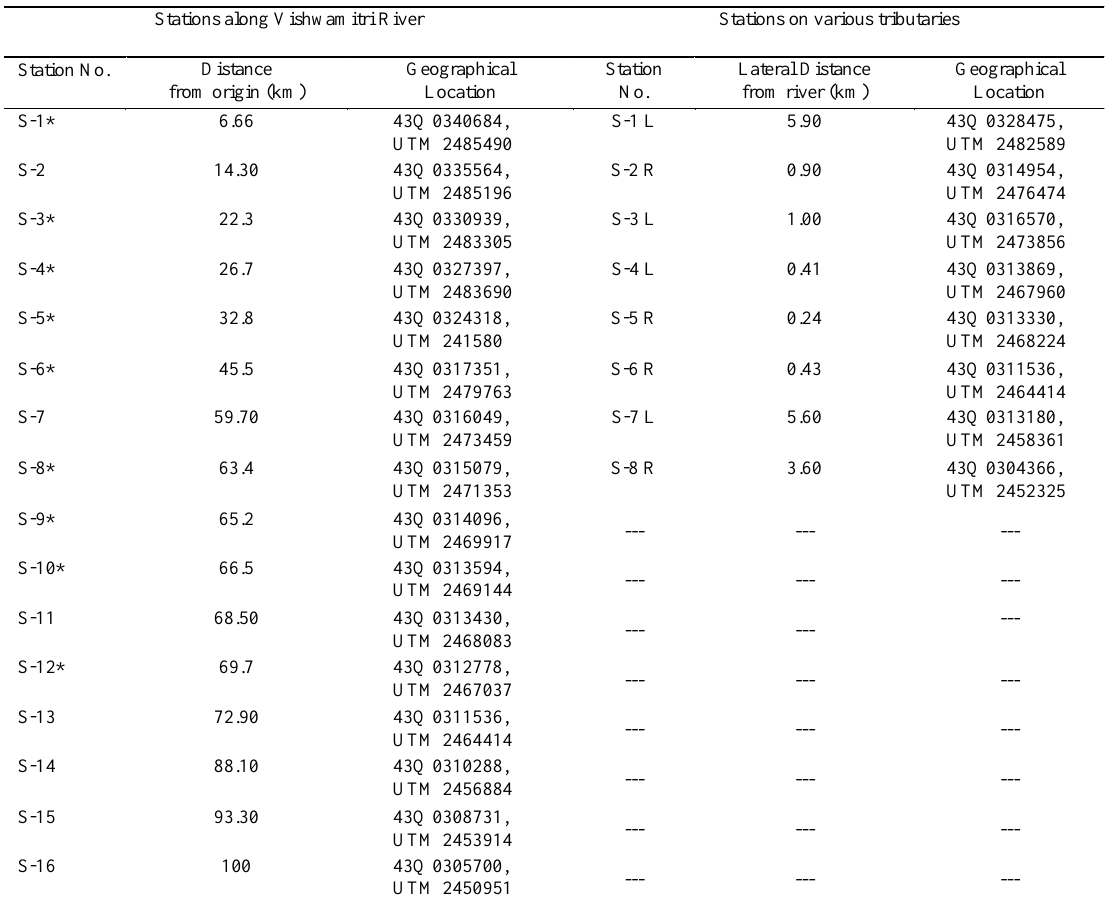
Table 2: Locations of Sampling Stations along Vishwamitri and its